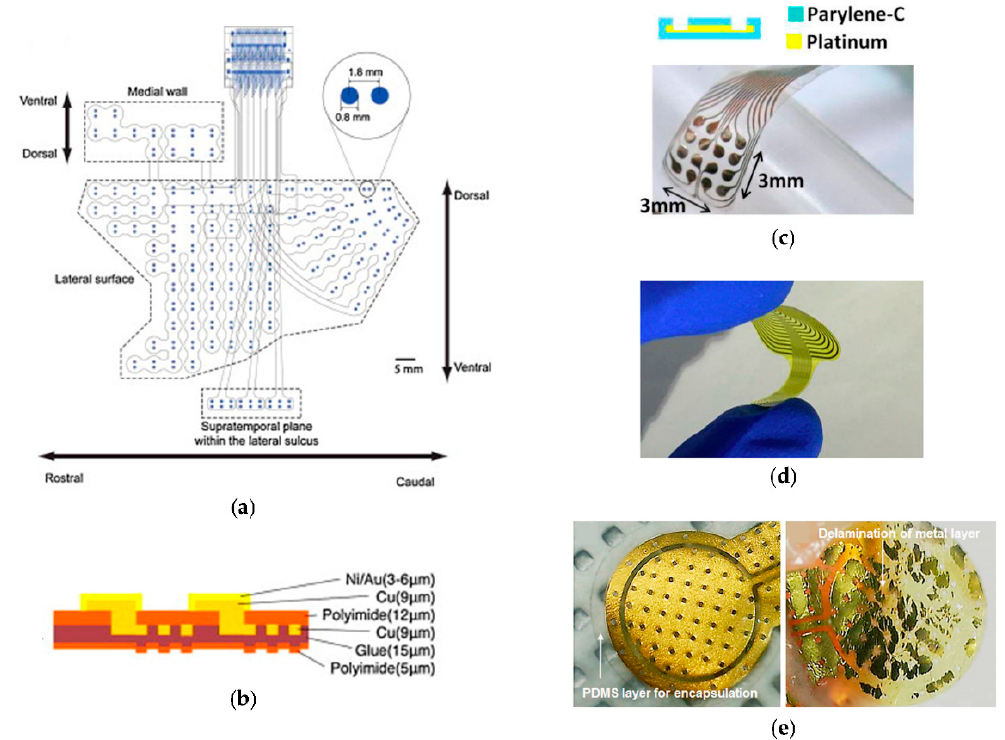
Figure 5. ( a ) Spatial layout of the 256 electrodes array for multisite recording [101]. The three sections outlined by the dashed lines, were designed for the medial wall (26 electrodes), the lateral surface (212 electrodes) and the supratemporal plane of the lateral sulcus (18 electrodes, STP array), respectively. A pair of electrodes designed for bipolar recording is magnified in the insert; ( b ) Schematic representation of a section of the array reported in ( a ). The total thickness of the electrode is 53–56 µm; ( c ) Photograph and schematic cross section of the 16 electrodes array reported in [110]; ( d ) Demonstration of the fl exibility of the 32 electrodes array reported in [111]; ( e ) PDMS- encapsulated (left) and non-encapsulation (right) electrodes, retrieved 4 weeks after subcutaneous in vivo implantation. ( a , b ) Reprinted from [101]. Copyright 2014, with permission from Elsevier; ( c ) Reproduced with permission from [110], MDPI, copyright 2013; ( d ) Reprinted from [111]. Copyright